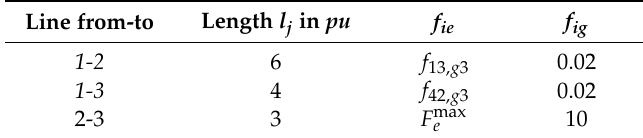
Table 3. Assumed line